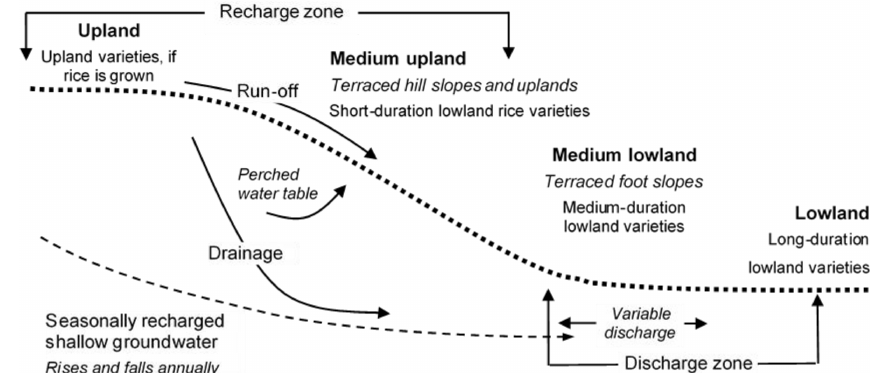
Figure 1. EIP landscape schematic (after Cornish et al., 2015a). Vertical relief is typically 2–100m and toposequence length 0.5–5km. Discharge areas may be defined drainage lines, ill-defined low-lying areas, or ephemeral streams. Medium lowland is a discharge area in wetter years only. Lowlands receive both run-off and discharge and historically have been used for lowland rice. Terraced and bunded foot slopes and hill slopes comprise around 80% of the present EIP rainfed rice area. Uplands may be categorised into several classes depending on the potential for crops (see text). Upland (non-transplanted) rice is